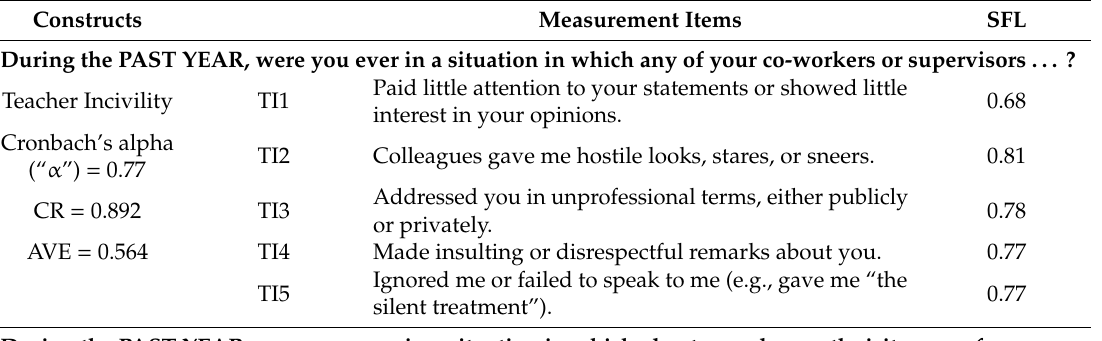
Table 2. Confirmatory factor analysis, teachers’